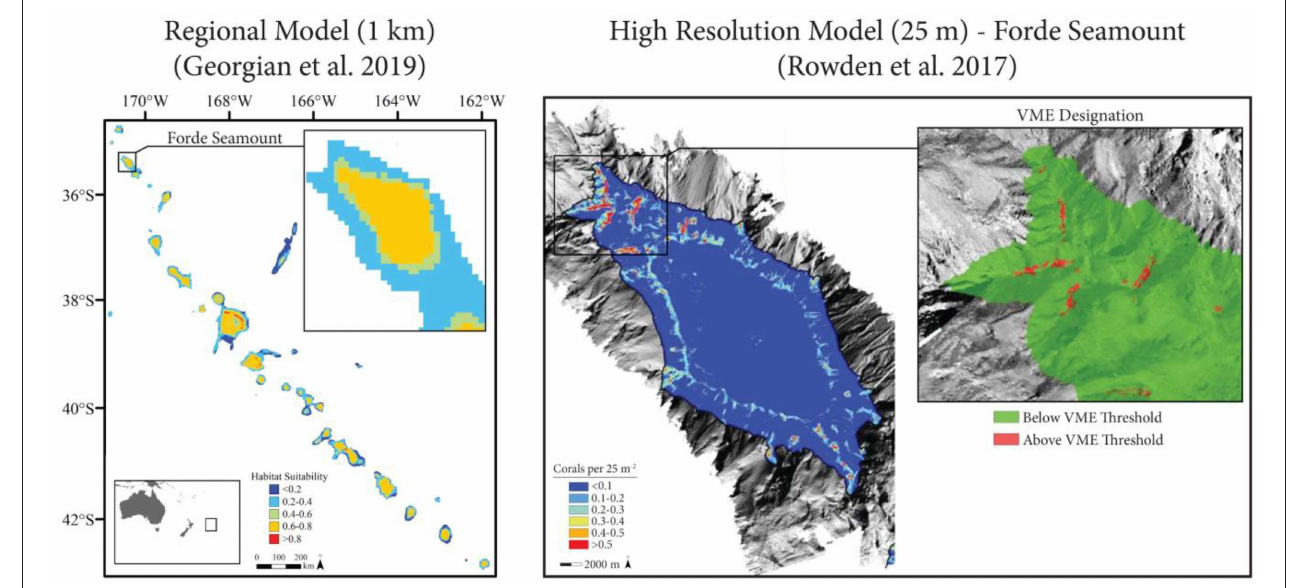
FIGURE 5 | Case Study 3: Louisville Seamount Chain (Rowden et al., 2017). Left: Regional habitat suitability models (1km, adapted from Georgian et al., 2019) indicated high suitability for the stony coral Solenosmilia variabilis throughout the Louisville Seamount Chain. Right: High resolution models (25m, adapted from Rowden et al., 2017) were constructed for six individual seamounts (Forde Seamount shown), and Vulnerable Marine Ecosystems (VMEs) were identified based on a threshold applied to S . variabilis abundance models.